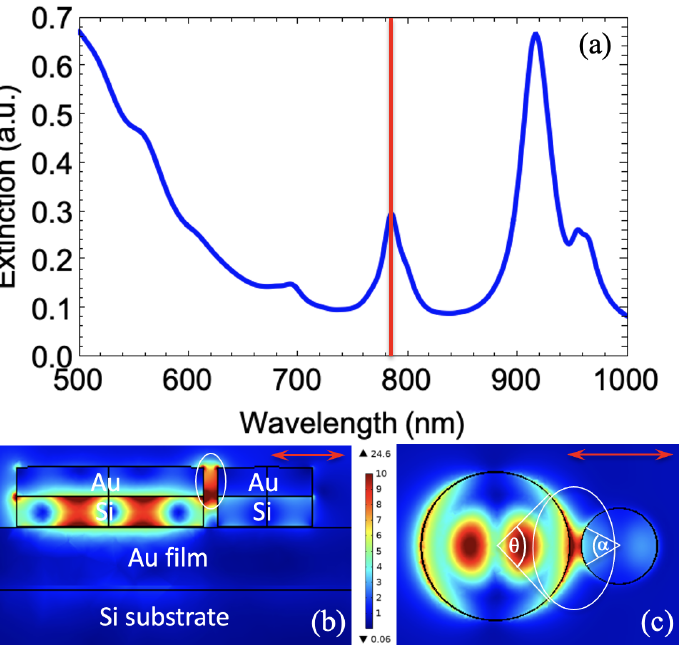
Figure 2. ( a ) Extinction spectrum calculated by FEM. The red line indicates the chosen wavelength of excitation. Electric field (E/E 0 ) mappings calculated at the excitation wavelength of 785 nm: ( b ) cross-section view and ( c ) top view. In each mapping, the double red arrow corresponds to the direction of the electric field in the laser beam oriented along the dimer axis. The white ellipses indicate the strong electric fields zones accessible for thiophenol molecules (gold part) and taken into account for calculating the EF value ( θ = 82 ◦ and α = 54 ◦ correspond to the part of the lateral surface to be taken into account for each nanodisk of